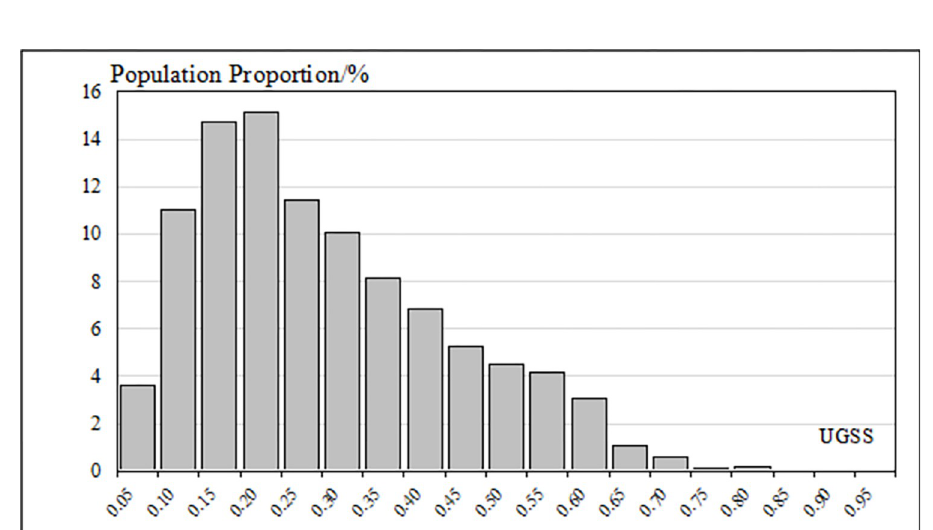
Fig 10. The distribution of population in UGSS results.